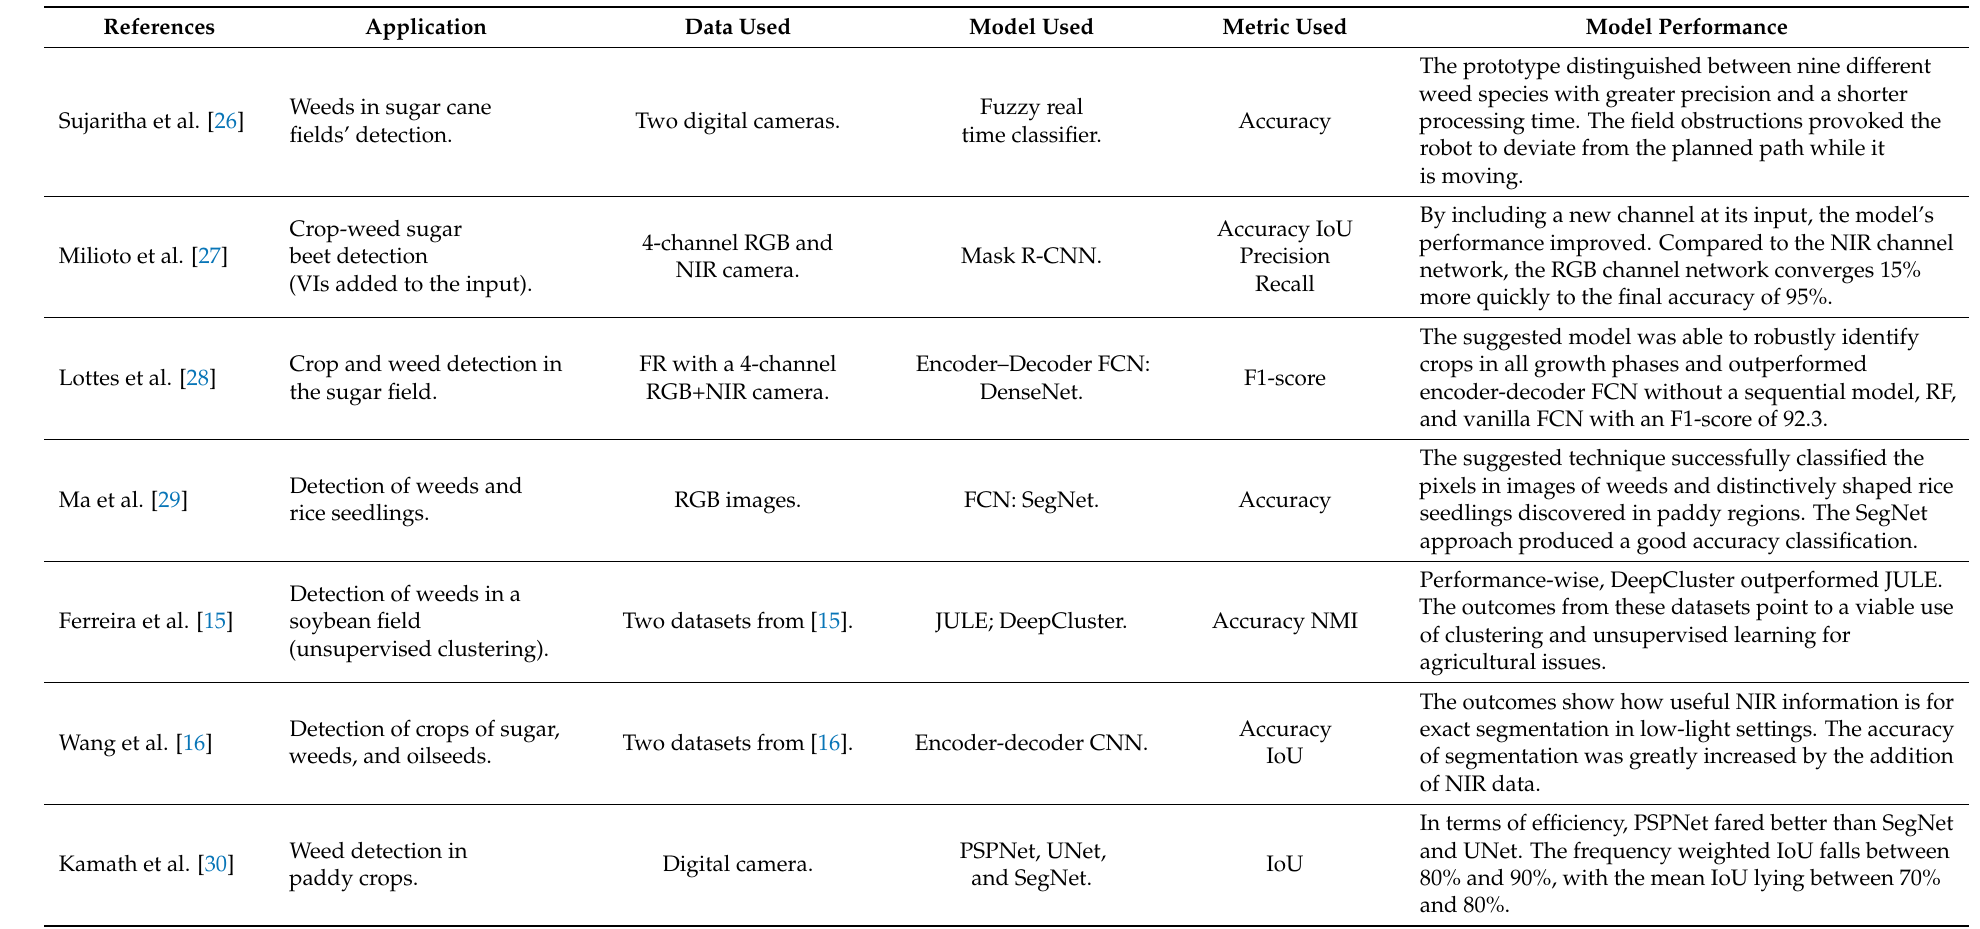
Table 4. Feature descriptions of publications in the field of “Weed